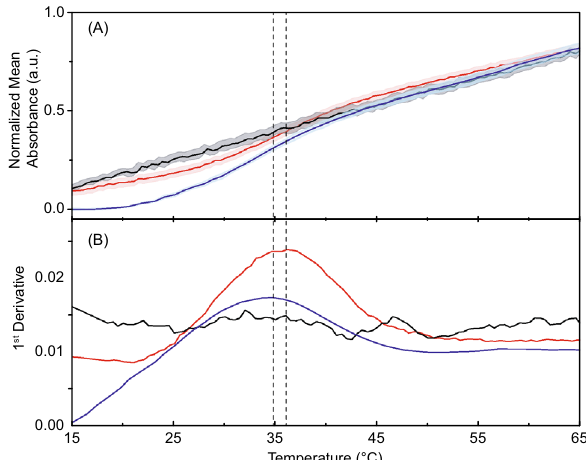
Figure 5. Analysis of the thermal stability of MN19 free and ligand-bound using UV melting plots. Shown in ( A ) are the normalized average of UV absorbance values at 260 nm versus temperature for the unbound MN19 (black), ART-bound MN19 (blue), and quinine-bound MN19 (red) as a positive control. Displayed in ( B ) are the first derivative plots. Dashed lines indicate the obtained T m points of the aptamer. Data acquired in PBS (pH 7.4), 3% (v/v) acetonitrile. Each data point denotes an average of three experiments with the error ribbons corresponding to one standard